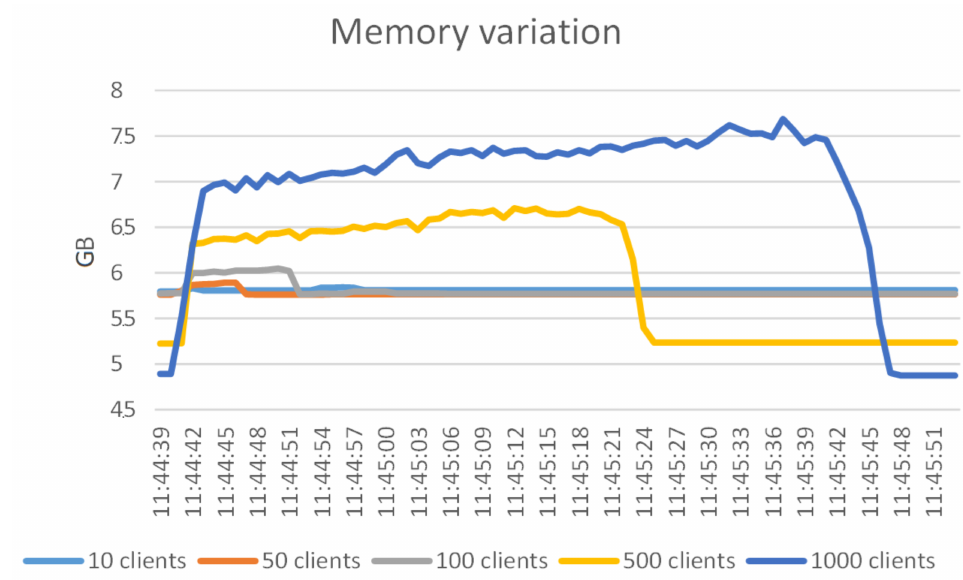
Figure 12. RAM consumption variation for different number of clients.